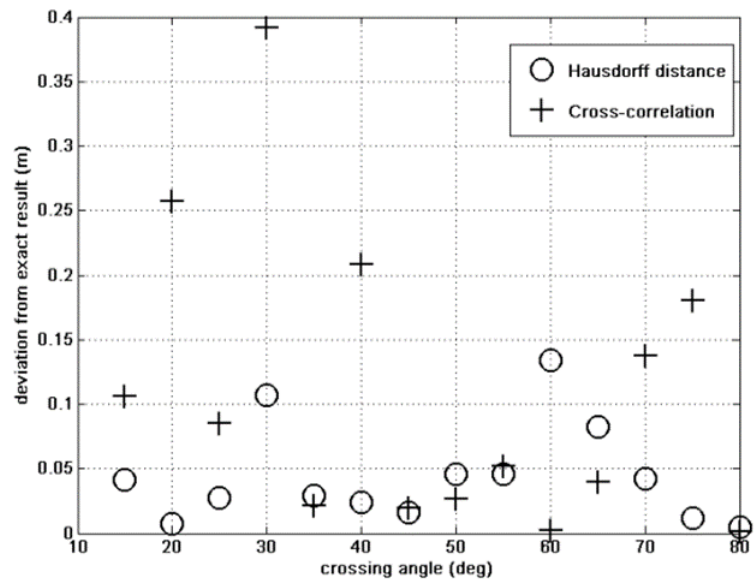
Figure 5. Crossing distance error: Hausdorff vs. cross correlation fitness.